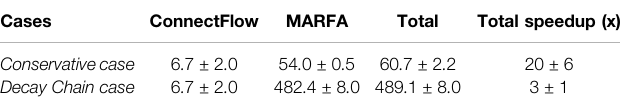
TABLE 6 | Collapsed plane runtime in seconds for the Conservative case and Decay Chain case , calculated as a mean over 10 realisations ± 1 σ and separated into ConnectFlow and MARFA components. Approximate speedup over the DFN model runtime in Table 5 is also